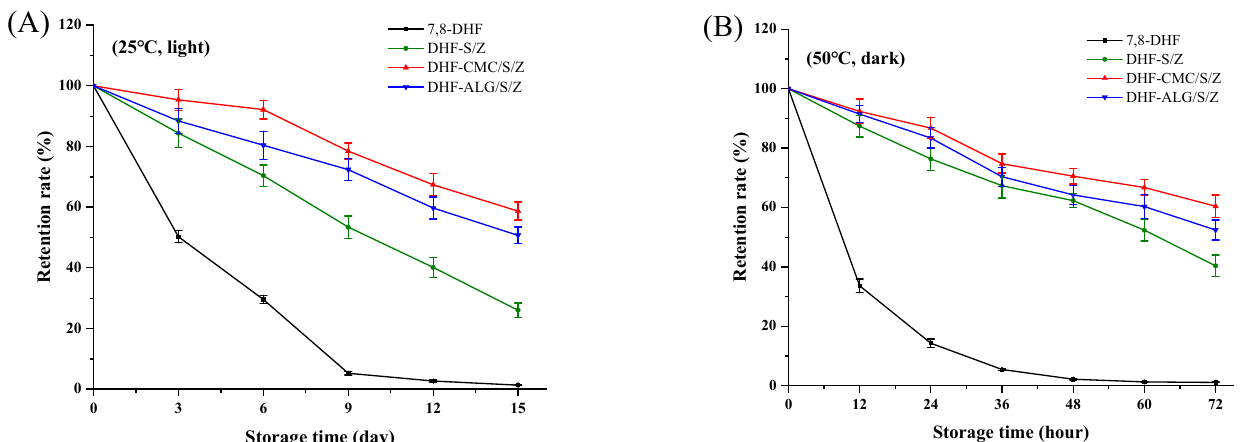
Figure 8. Storage stability of free 7,8-DHF, DHF-S/Z, DHF-CMC/S/Z and DHF-ALG/S/Z at 25 °C under light ( A ), at 50 °C under dark ( B ).